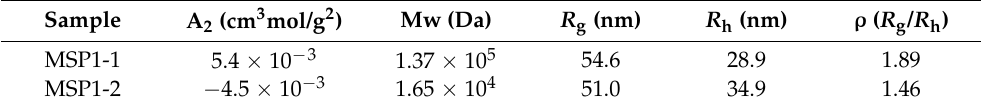
Table 3. Molecular parameters of MSP1-1 and MSP1-2 derived from Berry plots.